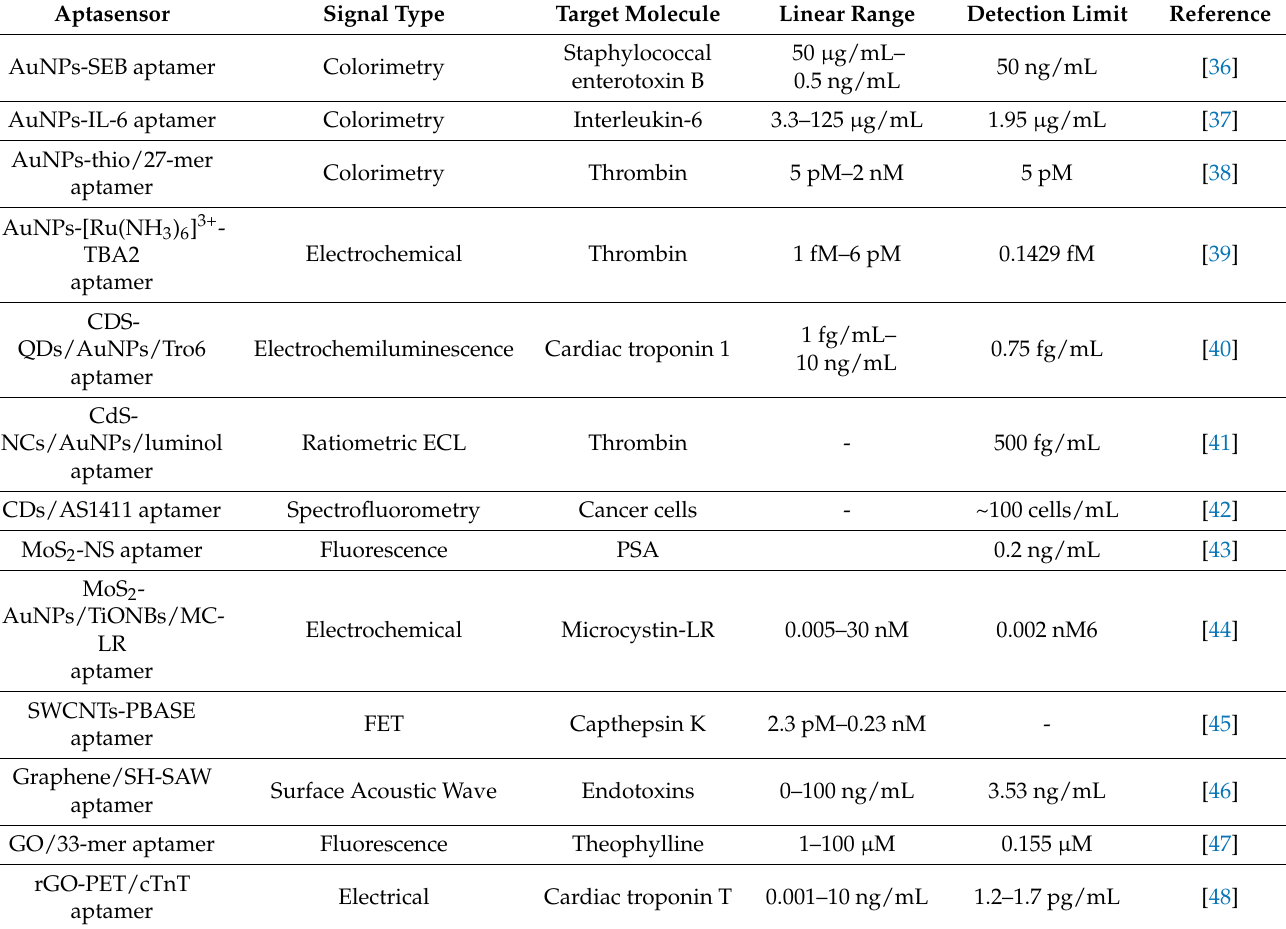
Table 2. Summary of aptasensors based on commonly used